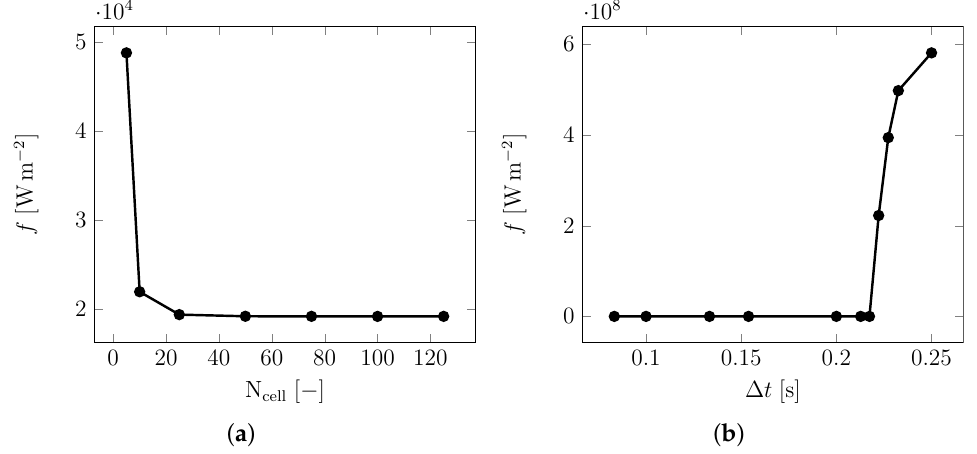
Figure 4. Convergence study. ( a ) Spatial discretization; ( b ) Temporal